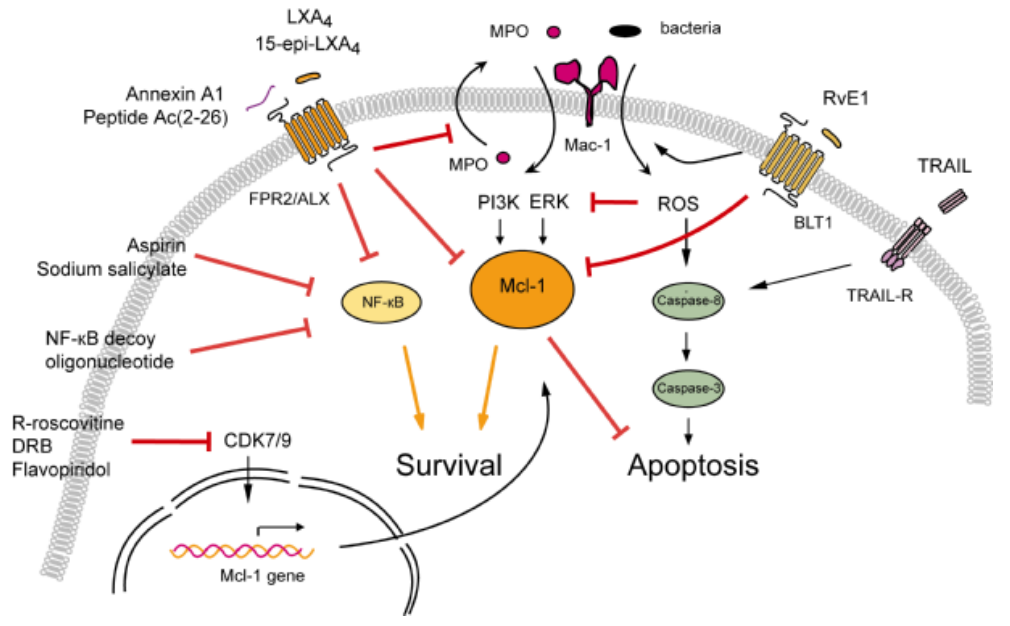
Figure 1. Proposed molecular mechanisms for neutrophil apoptosis-inducing agents with demonstrated pro-resolution properties in vivo . The adhesion receptor Mac-1 modulates the fate of neutrophils by integrating survival and pro-apoptosis cues. Ligation of the FPR2/ALX by lipoxin A (LXA )/aspirin-triggered 15-epi-LXA or annexin A1/peptide Ac 4 4 4 (2-26) counters Mcl-1 and NF- κ B-mediated survival signals and redirects neutrophils to apoptosis. Lipoxins also interrupts MPO-mediated self-amplifying loop. CDK inhibitor drugs induce apoptosis via down-regulating the transcription of the key survival protein Mcl-1. RvE1 through BLT1 enhances phagocytosis of bacteria and phagocytosis-induced ROS-mediated apoptosis. TRAIL induces apoptosis through activation of caspase-8. MPO, myeloperoxidase; ROS, reactive oxygen species.